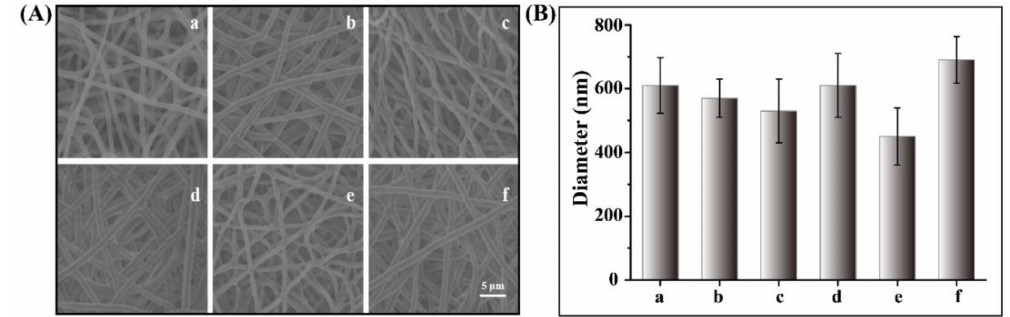
Figure 1. ( A ) SEM image of PCL based nanofiber meshes and ( B ) average diameters of nanofiber meshes (a: PCL, b: MNP-PCL, c: MNPs/DOX-PCL, d: MNPs/17AAG-PCL, e: DOX/17AAG-PCL, f: